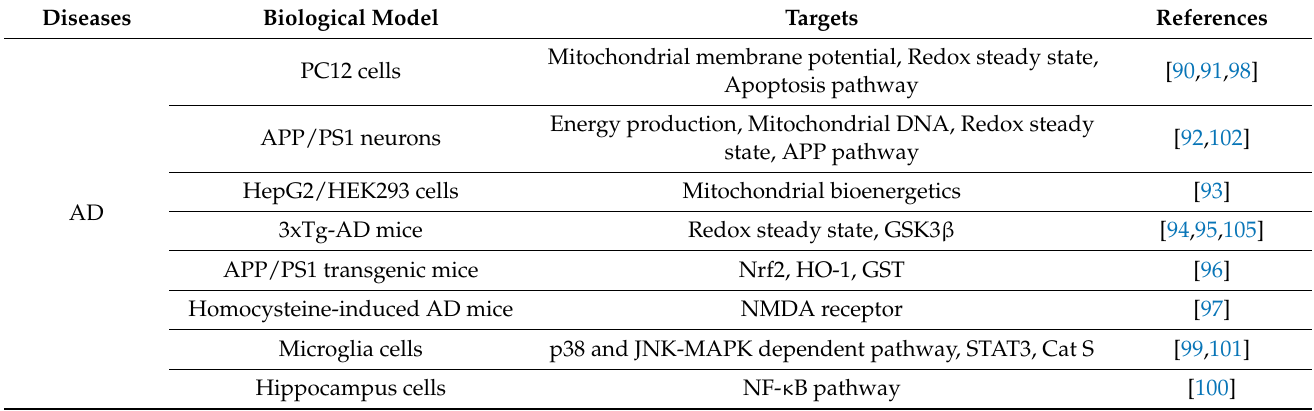
Table 1. Summary of the beneficial effect of H 2 S in neurodegenerative